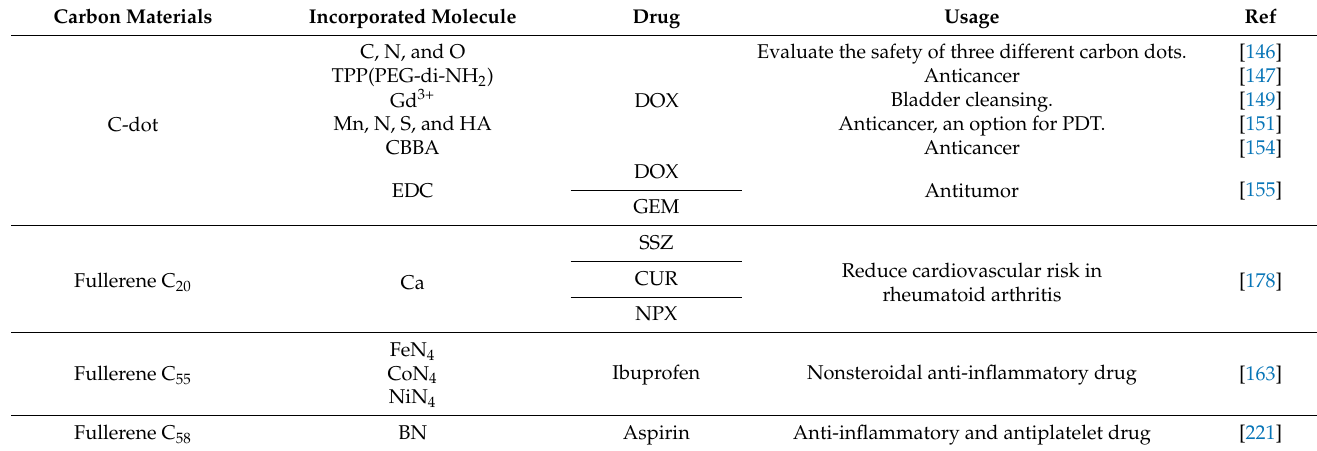
Table 5. Summary of carbon-based material for drug delivery